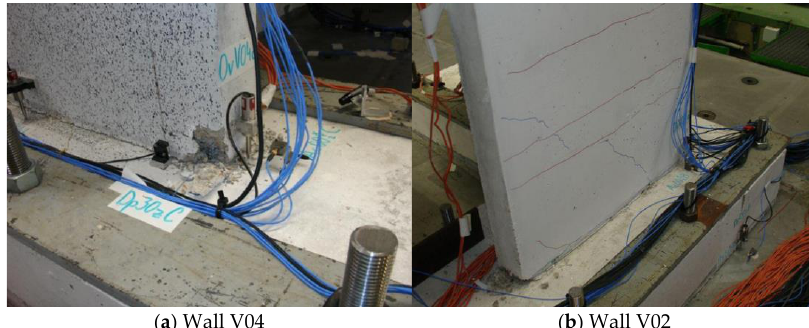
Figure 30. Damages in the lower part of the concrete walls connected to the foundation [23,30].